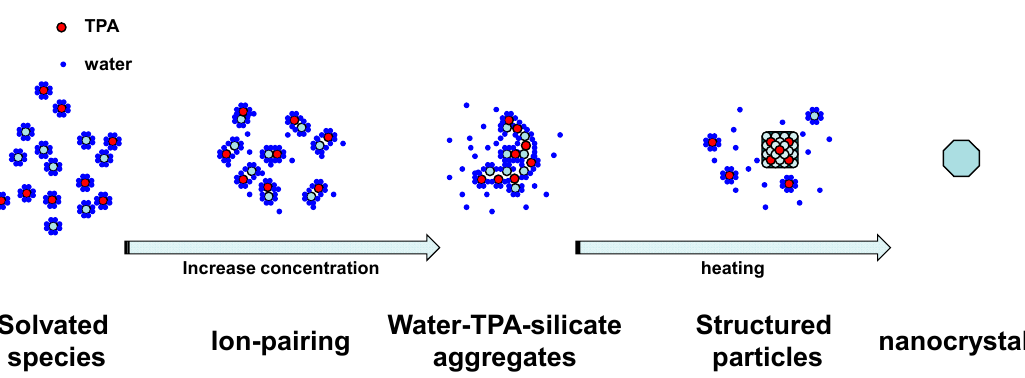
Figure 9. Progressive aggregation steps between hydrated silicate and TPA cations taking place upon increasing concentration, aging, and heating in a typical silicalite precursor.